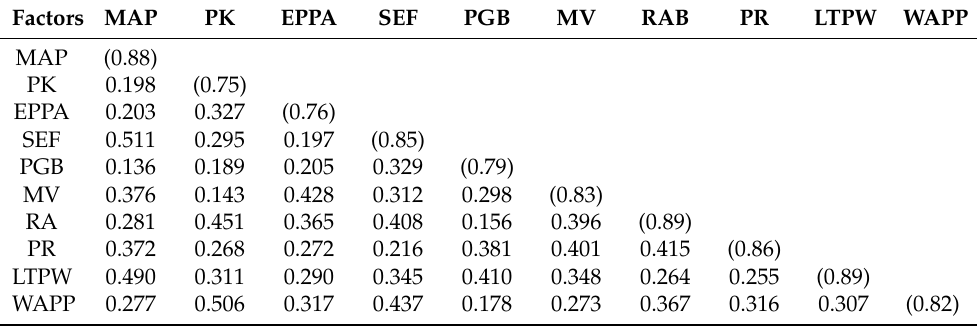
Table 3. Discriminant validity results based on Fornell and Larcker [106] criterion.